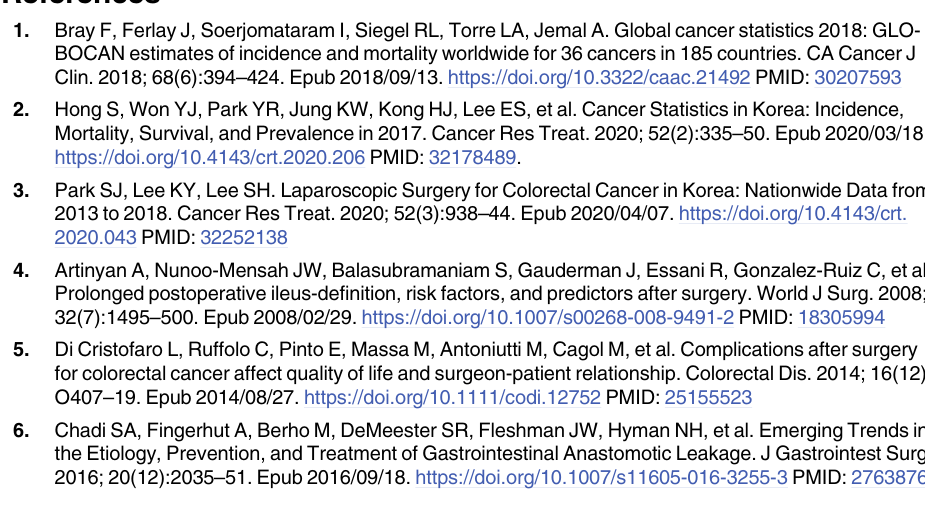
S1 Table. Economic outcomes of the presence of Additional Intervention